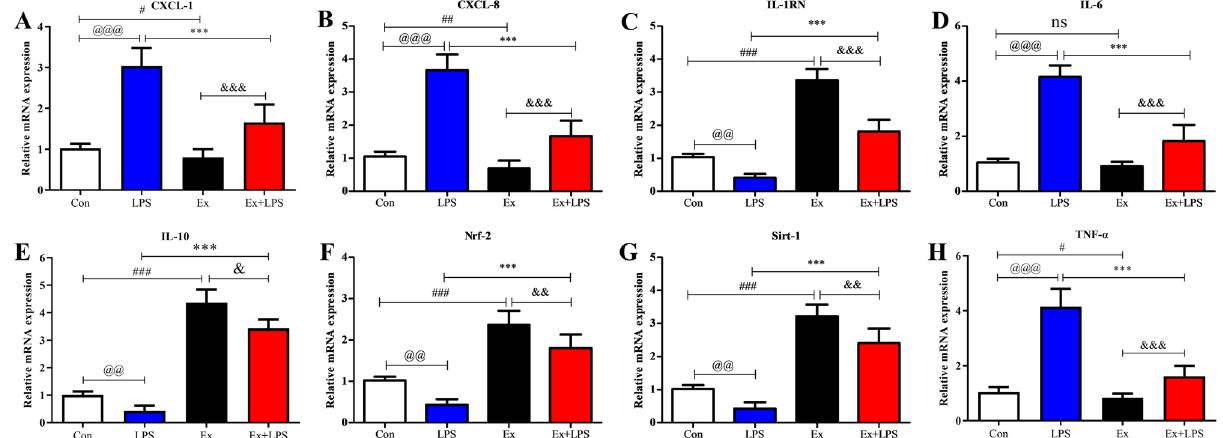
Figure 9. Detection of gene expression levels in lung tissues. The gene expression levels of CXCL-1 ( A ), CXCL-8 ( B ), IL-1RN ( C ), IL-6 ( D ), IL-10 ( E ), Nrf-2 ( F ), Sirt-1 ( G ), and TNF-α ( H ) were detected. @ P < 0.05, Con versus LPS groups; # P < 0.05, Con versus Ex groups; * P < 0.05, LPS versus Ex + LPS groups; & P < 0.05, Ex versus Ex + LPS